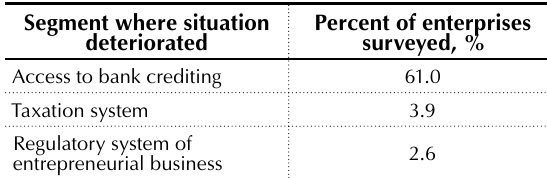
Table 10. Ranking of segments where the situation deteriorated